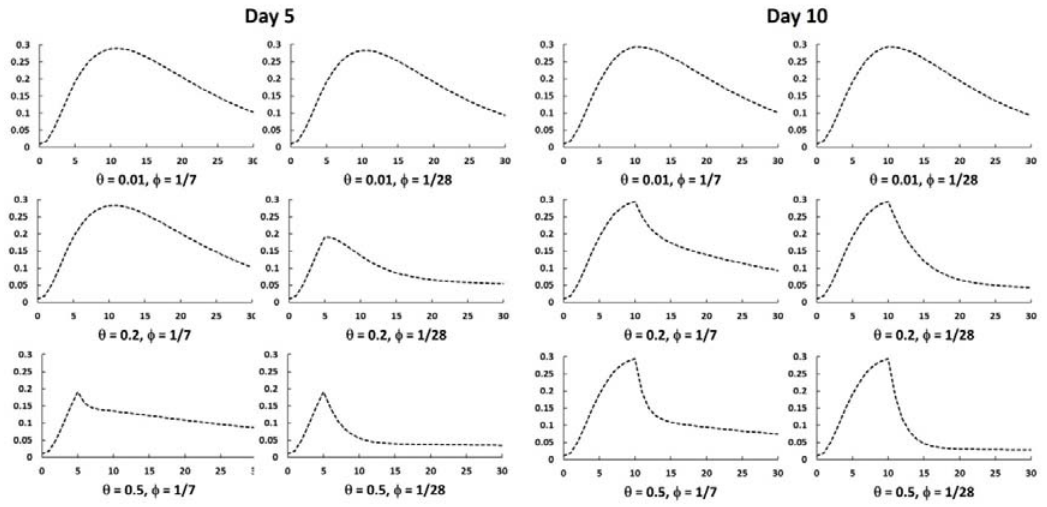
Figure 4. Impact of chemoprophylaxis initiated at day 5 and at day 10, at varying rates ( θ ) and